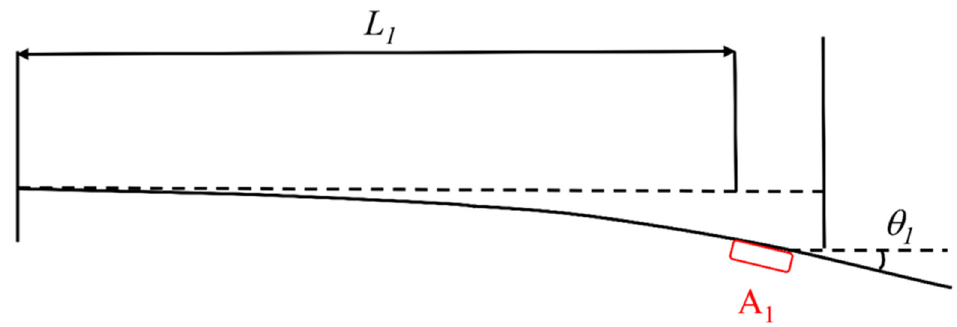
Figure 6. Principle of deflection monitoring.